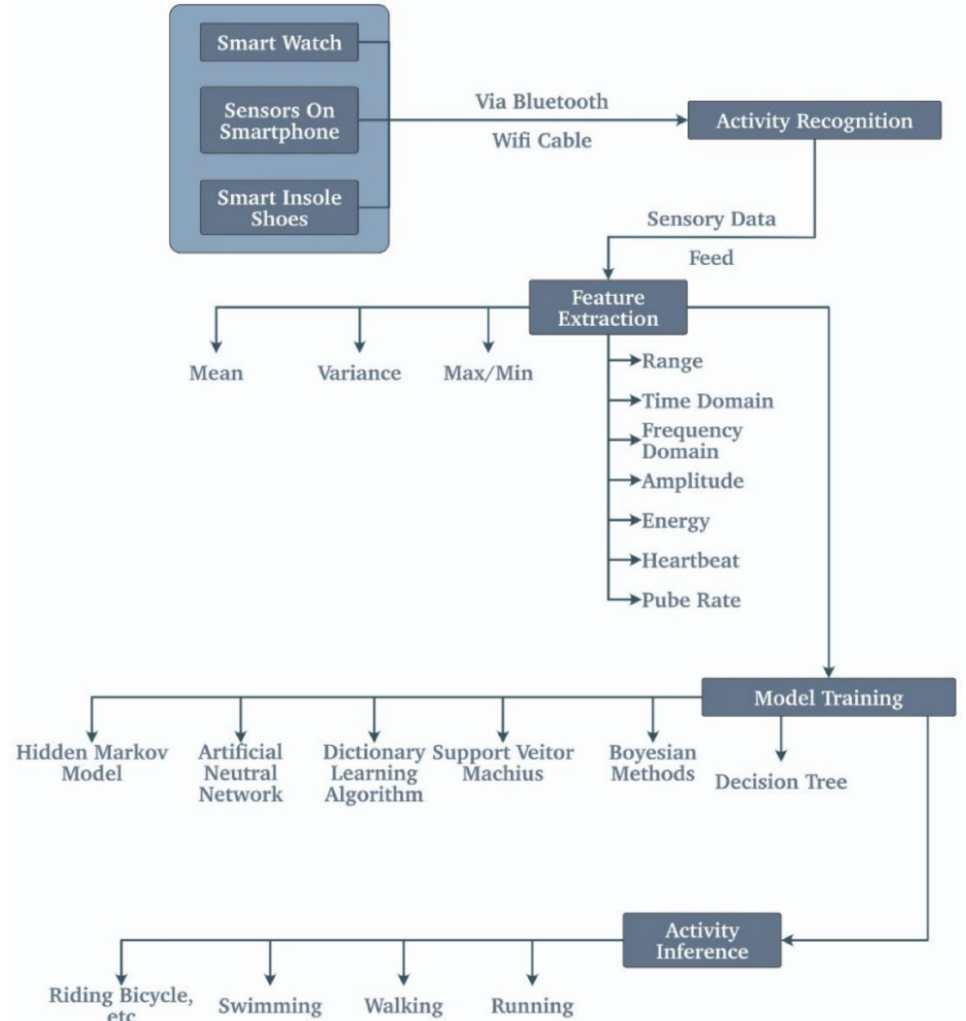
Figure 6. A brief overview of activity recognition